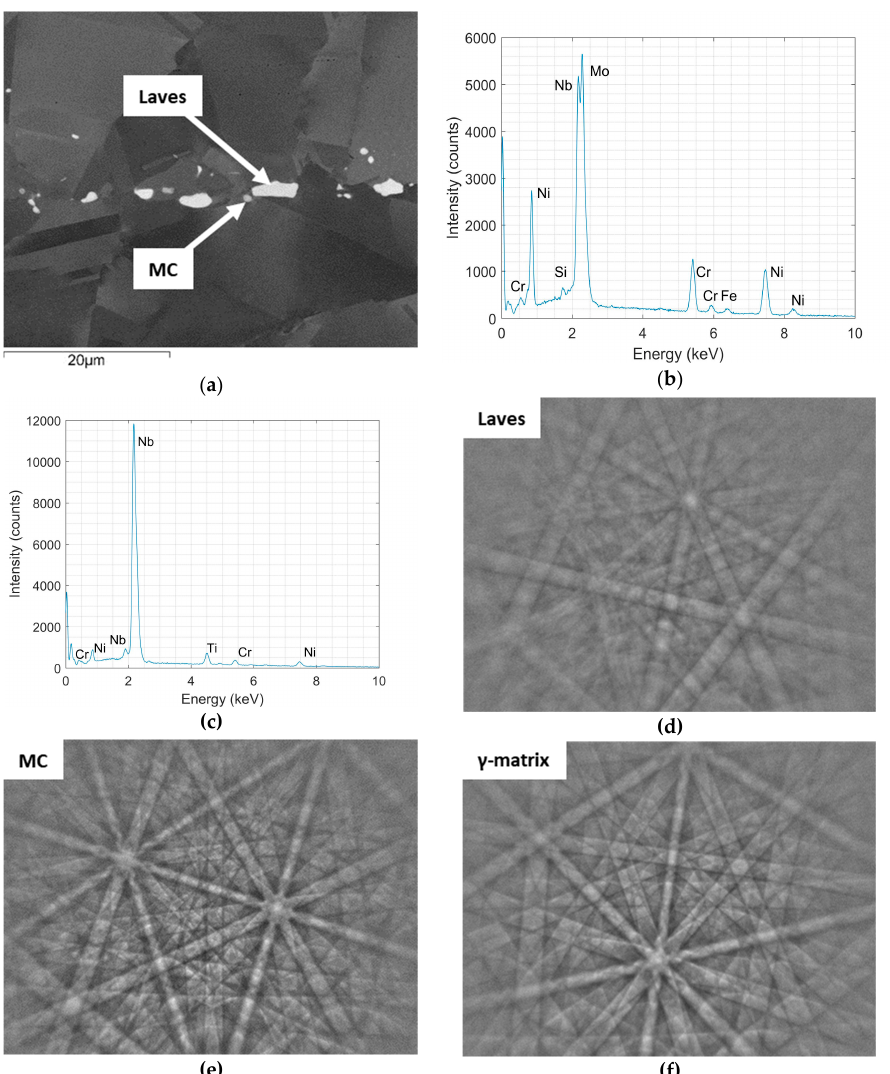
Figure 6. Backscatter-electron image (BEI) of a M(C,N) carbo nitride particle in plate hot rolled at 1050 ◦ C with the deformation level of 4.6% (not aged) ( a ) and EDS spectrum of a M(C,N) carbo nitride ( b ). Metals 2019 , 9 , x FOR PEER REVIEW